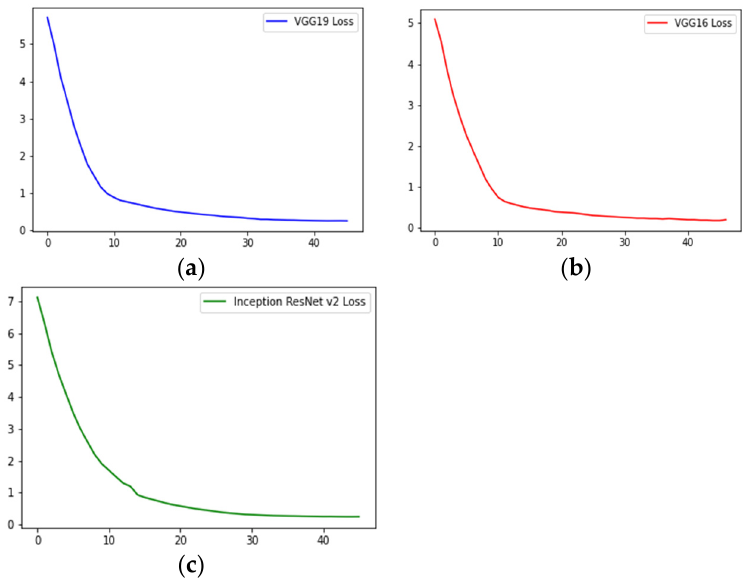
Figure 12. Validation loss vs. number of epochs of ( a ) VGG-16, ( b ) VGG-19, and ( c ) Inception-ResNet v2.